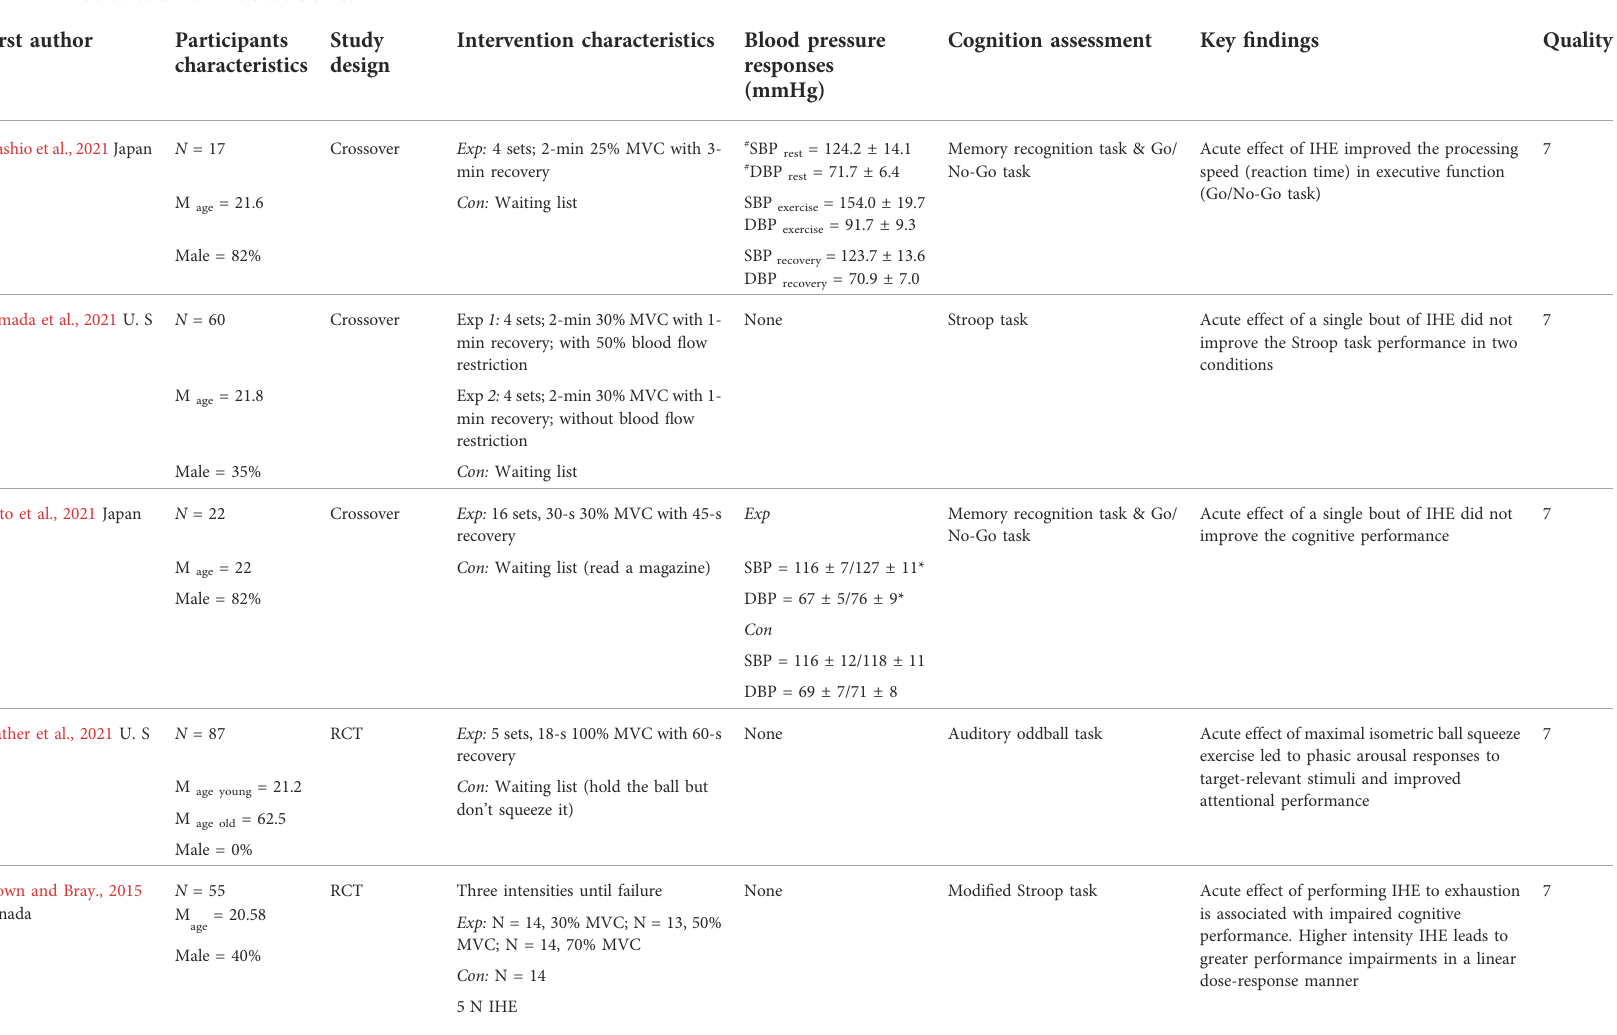
TABLE 1 Extracted data from included